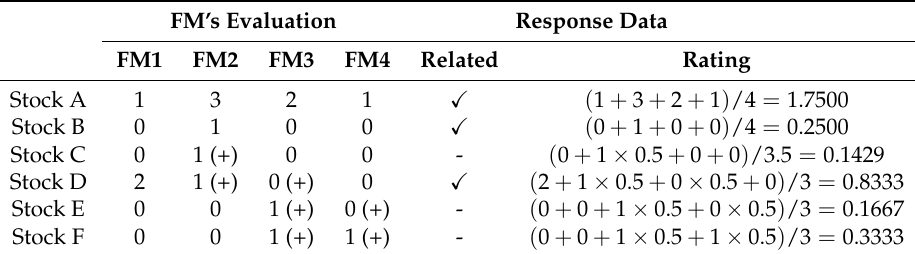
Table 5. Examples of converting fund managers’ evaluation data into response data.